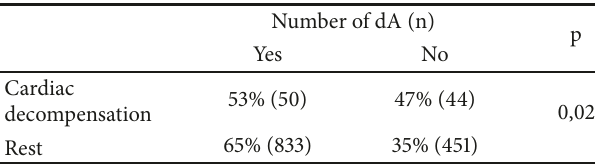
(ii) Special attention in the prehospital mission